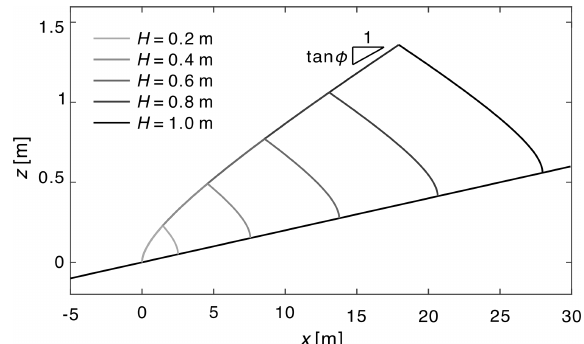
Figure 5. Analytical solutions for the centerline profiles of cohesive-frictional deposits on an inclined plane of slope tan β = 0 . 02 for different deposit heights assuming identical material prop- erties tan φ = 0 . 05, τ Y / ( ρg ) = 0 .